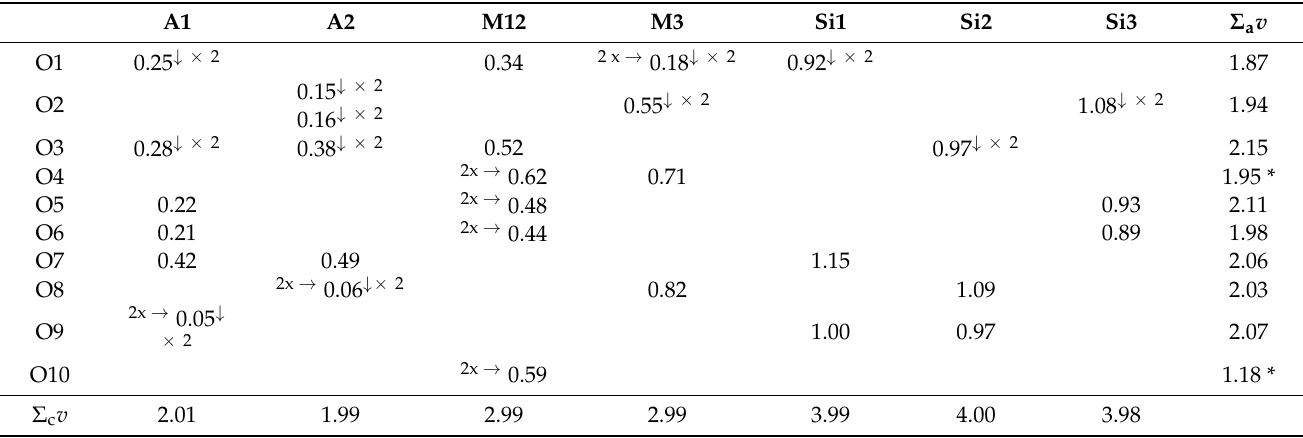
Note: left and right superscripts indicate the number of equivalent bonds involving anions and cations, respec- tively. Bond valences have been weighted for sites with mixed occupancy in structural refinement. * Anion